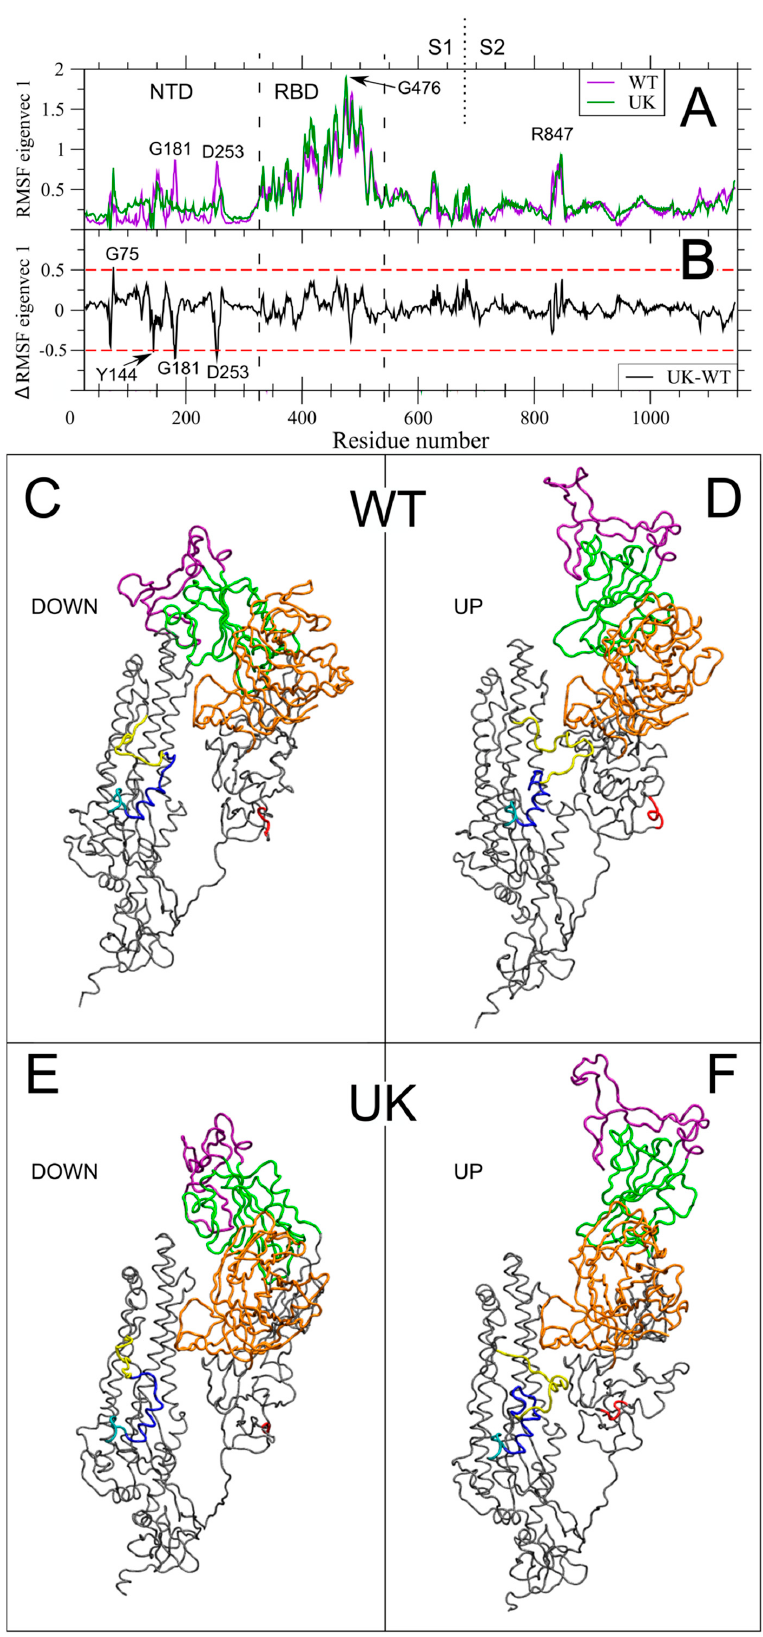
Figure 3. Long-range correlated motions along Essential Dynamics V1. ( A ) RMSF of the S protein filtered trajectory along V1 for WT and UK are reported in purple and dark green,